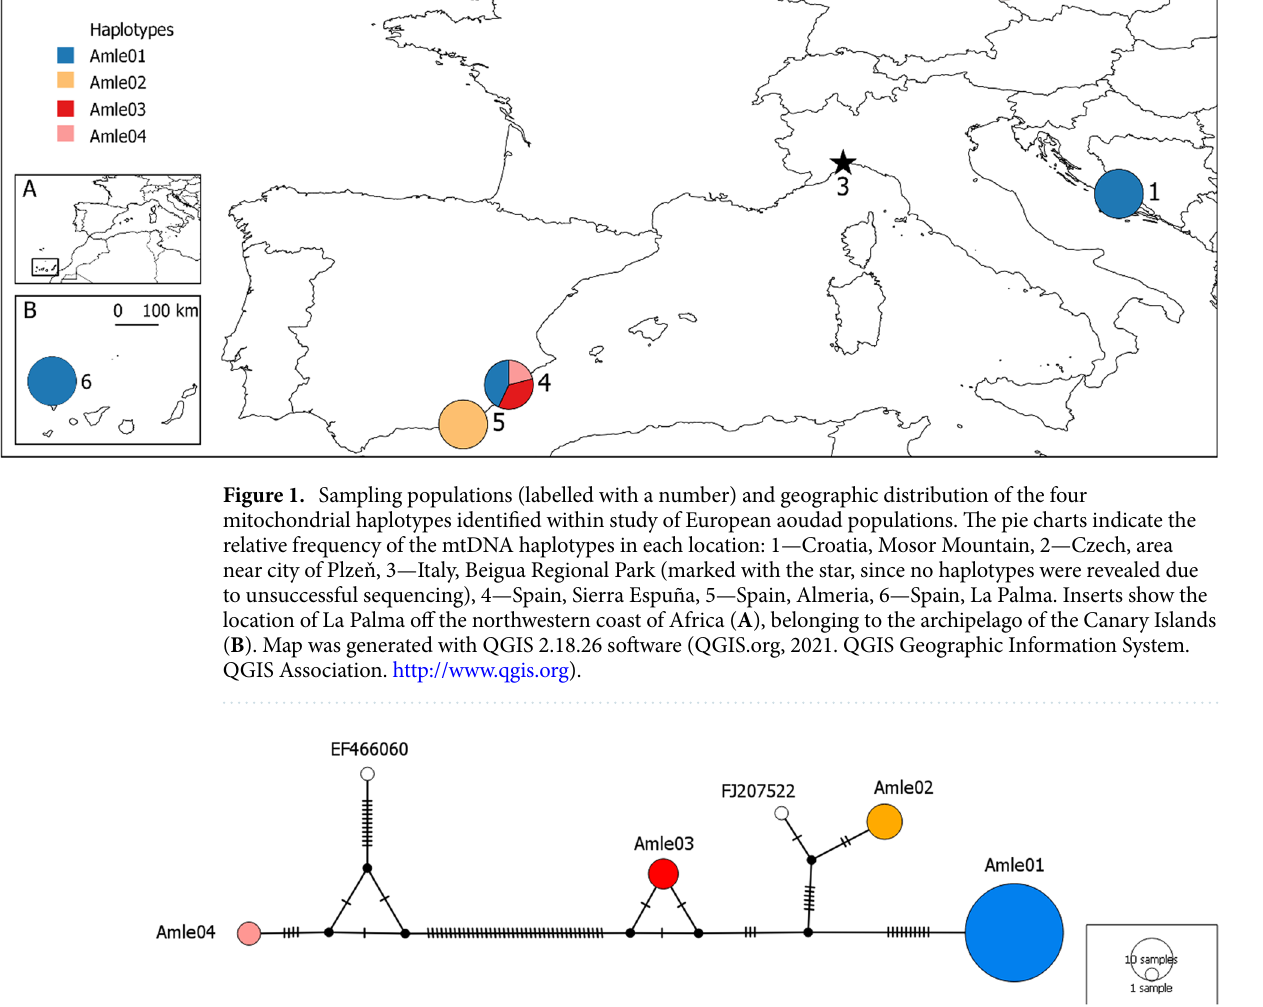
Figure 2. Median ‐ joining network based on the 606-bp mitochondrial control region haplotypes identified in European aoudad populations. Haplotypes are represented by circles with sizes proportional to the number of individuals. Colors assigned to each haplotype are matching those in Fig. 1, with two haplotypes from GenBank (EF466060 and FJ207522) colored in white. Number of mutations separating nodes is represented by slashes crossed with the network